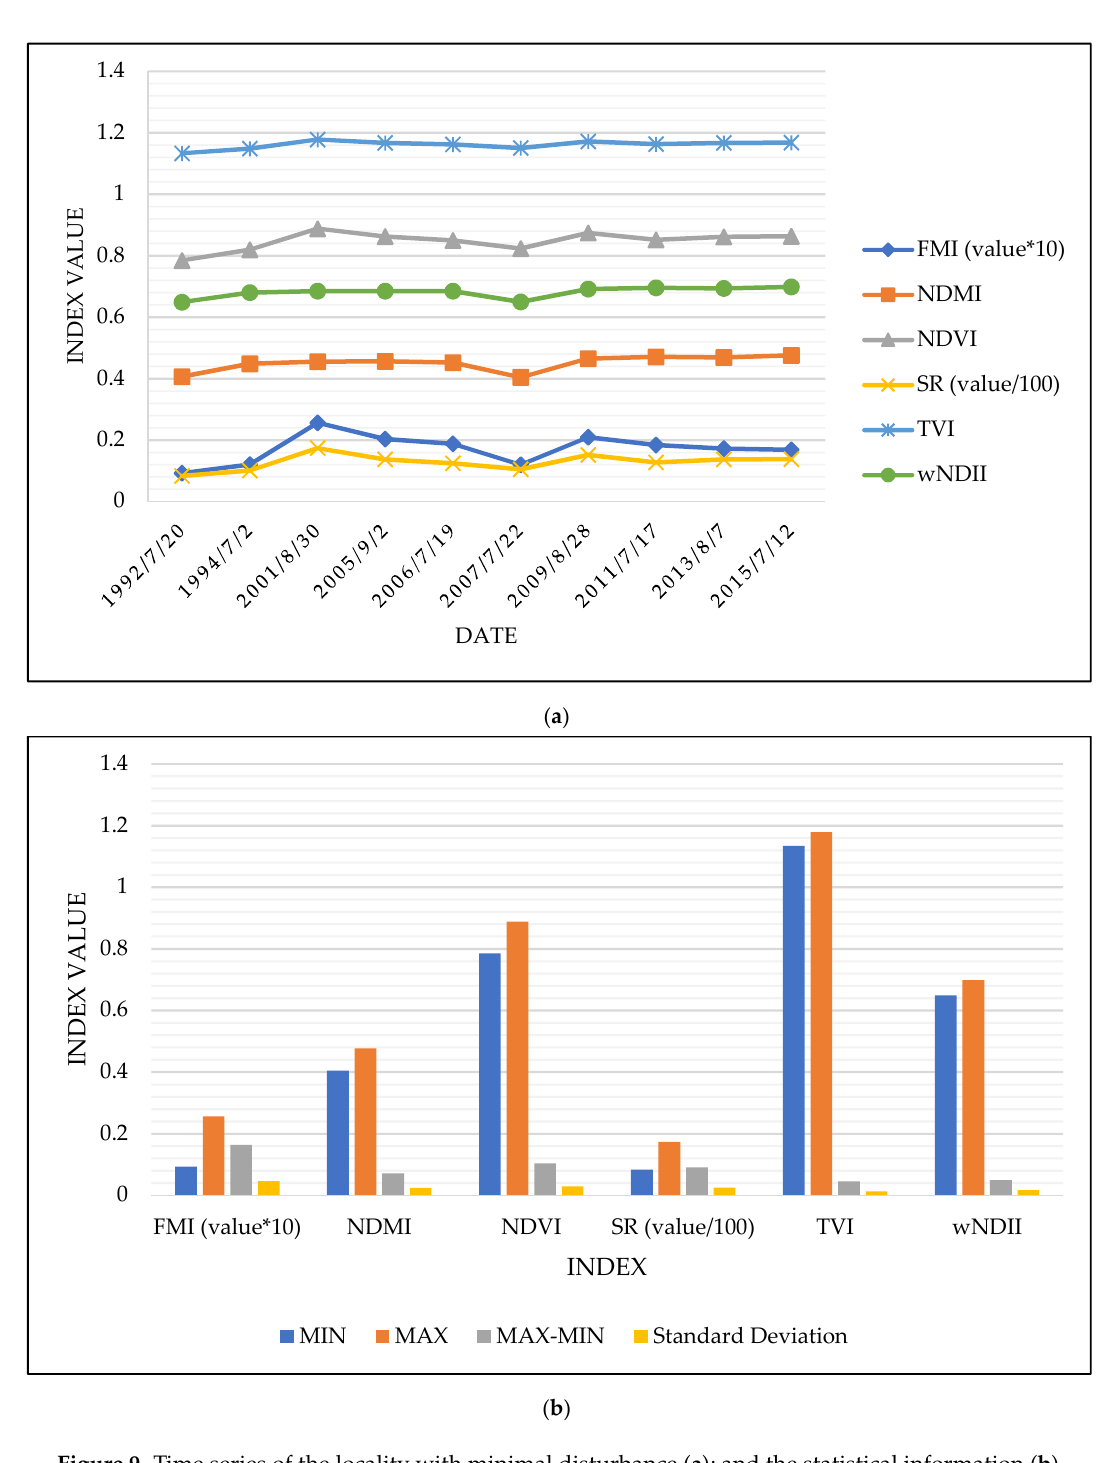
Figure 9. Time series of the locality with minimal disturbance ( a ); and the statistical information ( b ) (Locality 5) (Source: Own work).